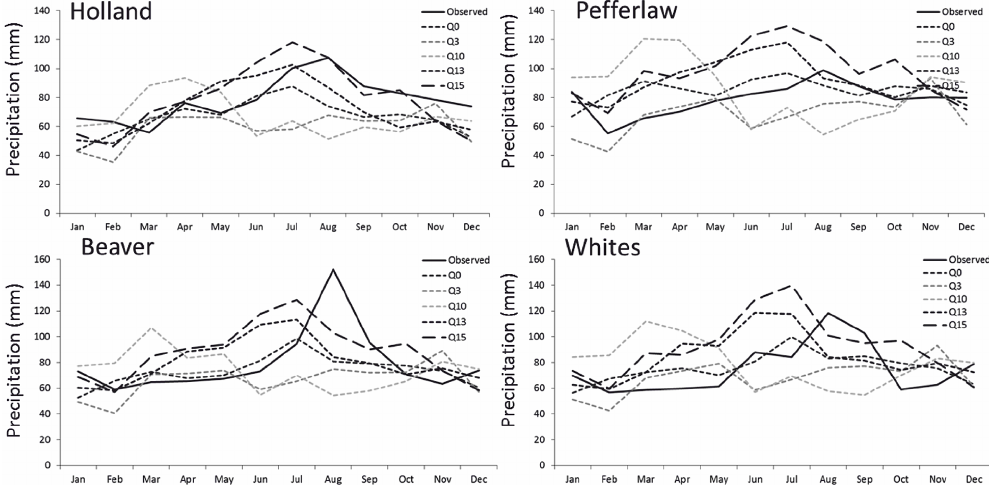
Figure 3. Comparison of monthly precipitation data from 5 ensemble members (Q0–15), regionally downscaled using PRECIS, with ob- served meteorological station data over 30 year baseline period